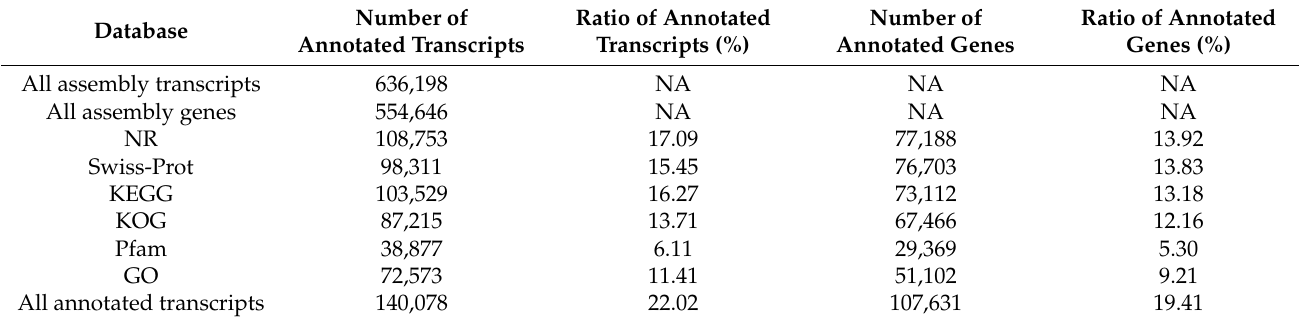
Table 1. Statistical results of transcript